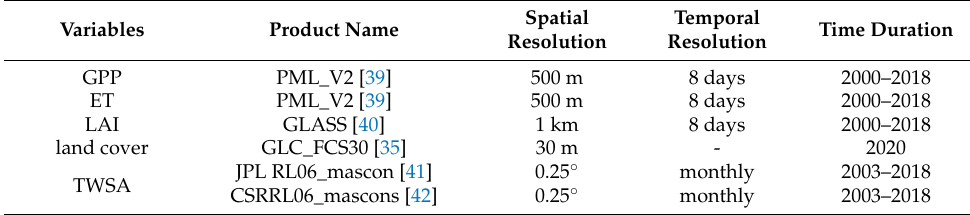
Table 1. Remote sensing products used in this study.